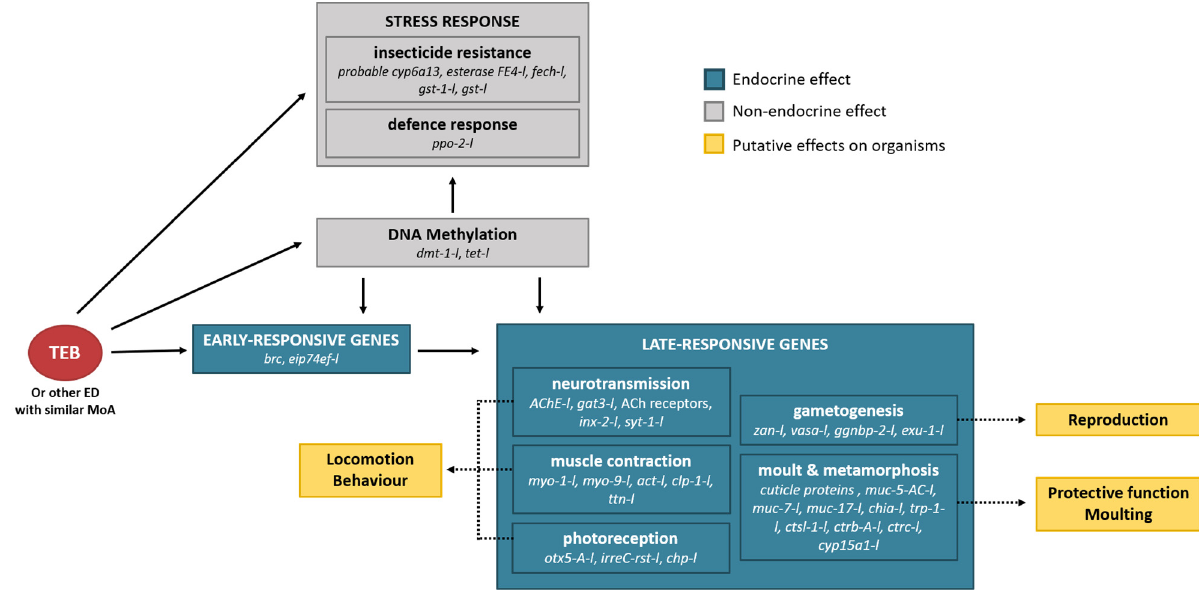
Figure 3. Representation of the putative effects triggered by TEB or other EDs with a similar mode of action on adult male and female E. affinis . Grey and blue panels represent the mis-regulated genes and main biological functions observed at the molecular level by the transcriptomic analysis performed in the present work. Yellow panels and dotted arrows represent putative effects triggered by the mis-regulation of those genes at higher biological levels.